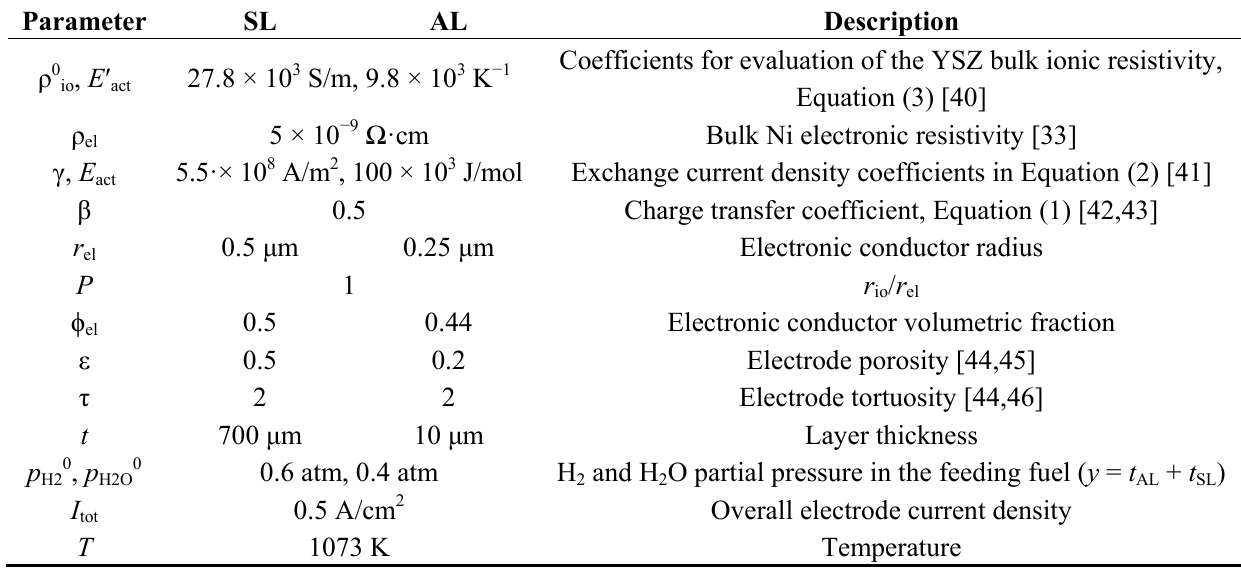
Table 2. Base-case bi-layered Ni-YSZ anode: model parameters and operating conditions. Parameter SL AL Description Coefficients for evaluation of the YSZ bulk ionic resistivity, Equation (3)